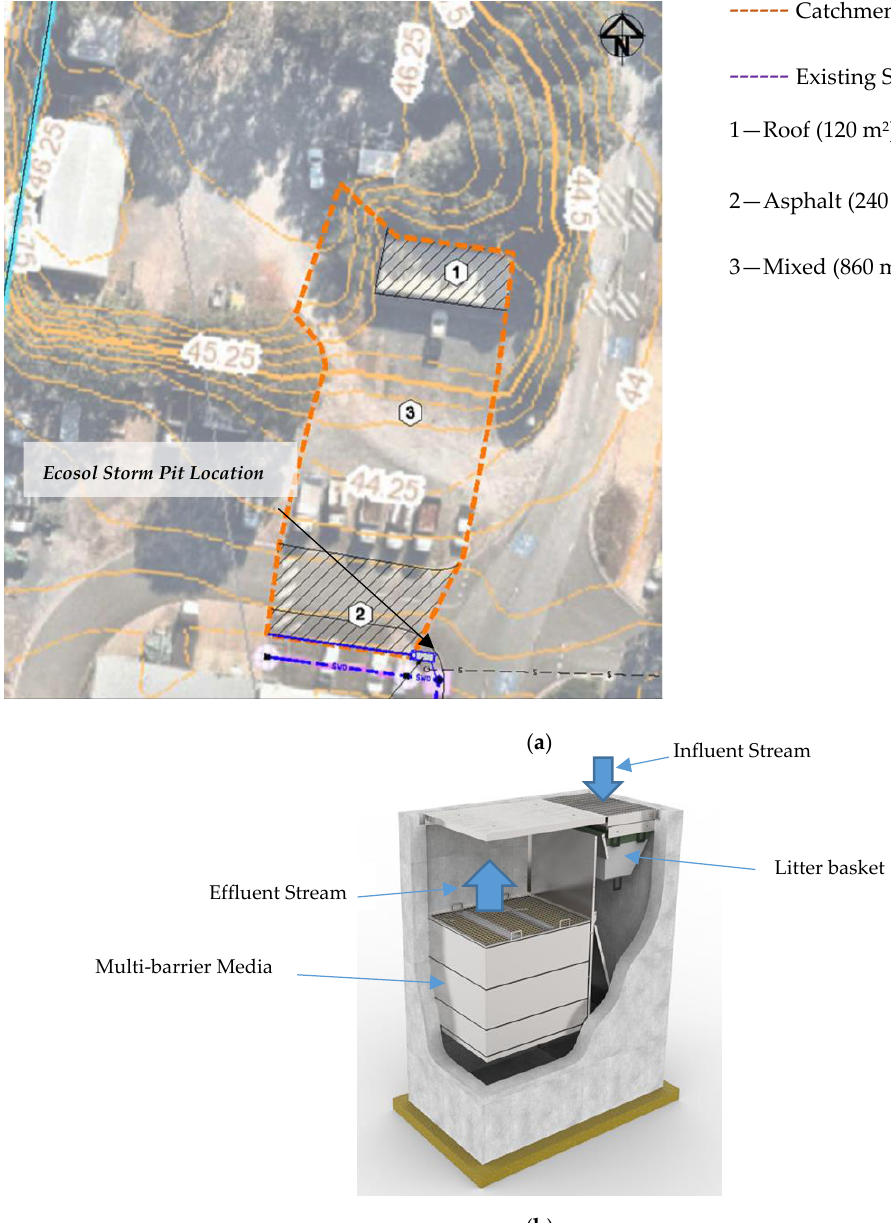
Figure 1. ( a ) Existing site layout and catchment plan [8]; ( b ) Ecosol Storm Pit (Class 2) [3].